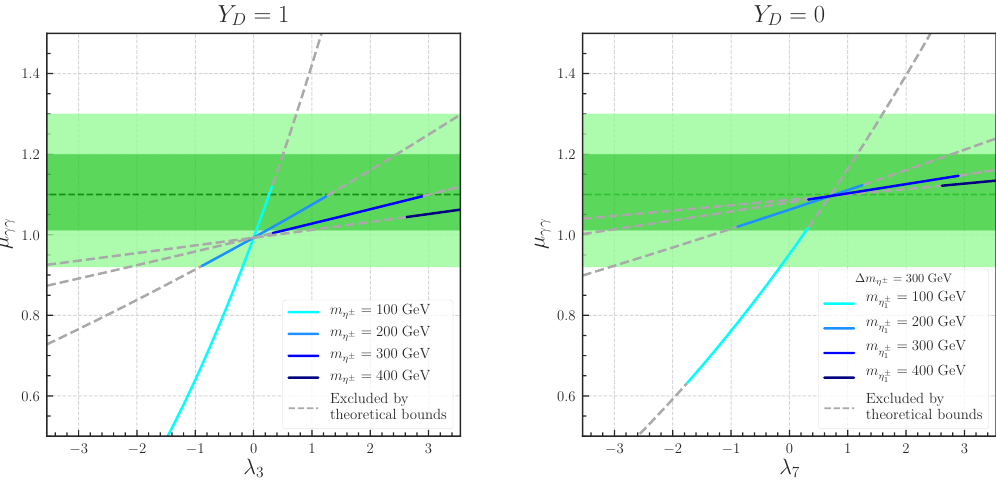
Figure 11 . Signal strength (cid:22) (cid:13)(cid:13) in the model with Y D = 1 (left) and Y D = 0 (right). The dark (light) green band shows the current global average of (cid:22) Exp with 1 (cid:27) (2 (cid:27) ) uncertainty. For Y D = 0, (cid:13)(cid:13) we take ( m (cid:17) ; m (cid:17) ; (cid:18) ) = (80 GeV ; 200 GeV ; (cid:25)= 4), and the mass splitting between the two charged H A scalar bosons is (cid:12)xed to be 300 GeV.